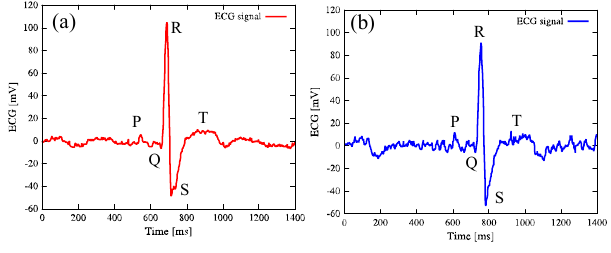
Figure 4: Acquired ECG signals. (a) Stopping, (b) driving.